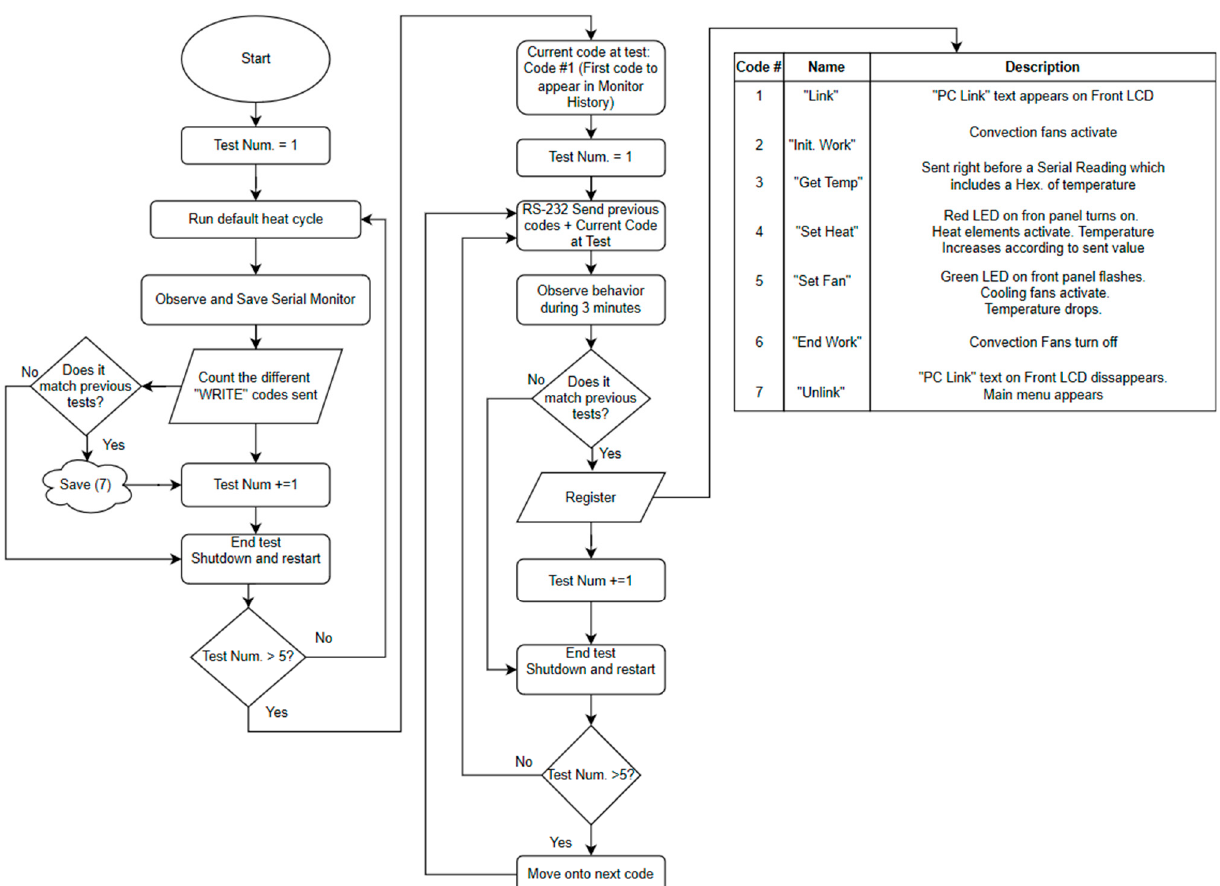
Figure 6. Flow diagram of experimental tests (Total of 40). Table 1. The seven functions of PC-Link Mode.